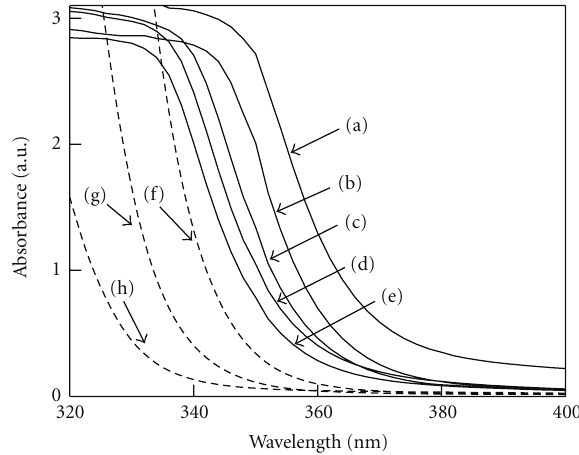
Figure 4: UV-VIS absorption spectra of the sols obtained by heat- ing the mixture of ethylene glycol solution of TIP and NH 3 (aq) at 368K for 24 h. The solid line shows the spectra of the obtained sols. The NH 3 (aq) concentrations were (a) 0.05 mol/L, (b) 0.1mol/L, (c) 0.2 mol/L, (d) 0.5 mol/L, and (e) 1 mol/L. The broken lines show spectra of the isopropanol solution of TIP. The TIP concentrations of the solutions were (f) 1mol/L, (g) 0.1mol/L, and (h) 0.01mol/L.